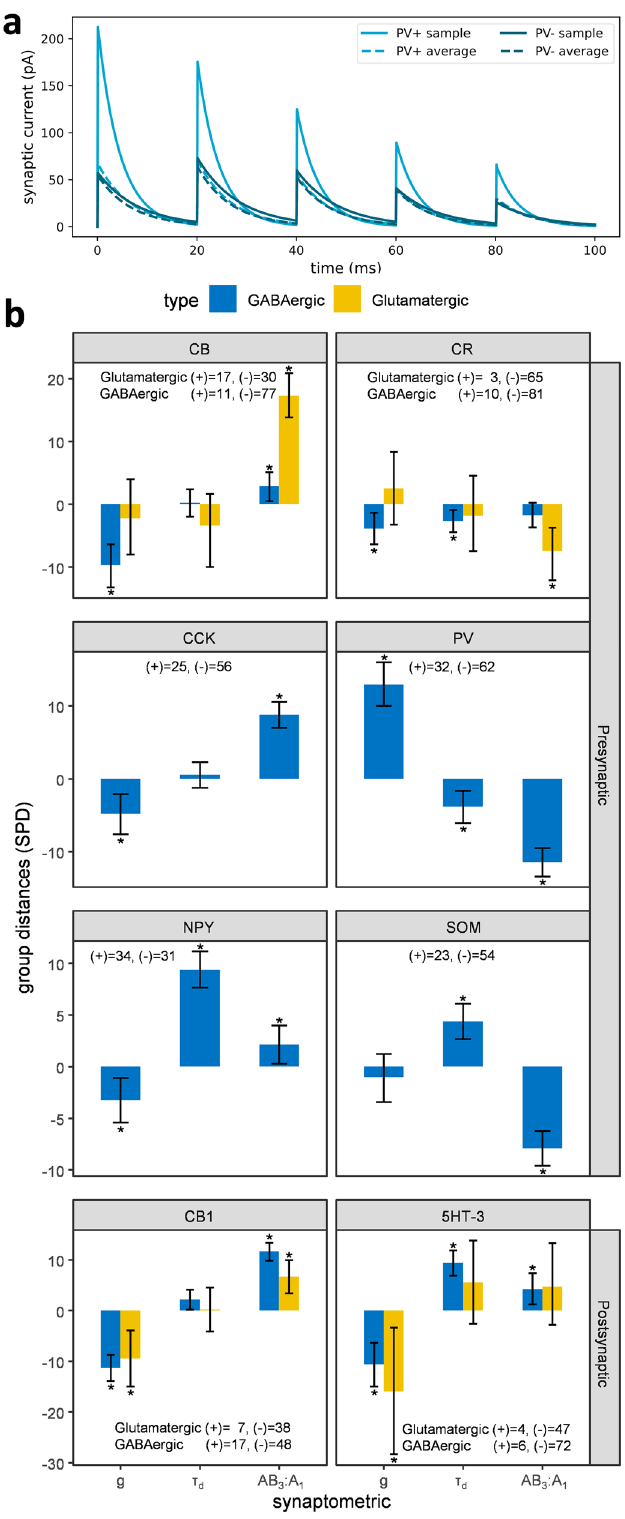
Fig. 8 Presynaptic and postsynaptic molecular markers of synaptic physiology. a Comparison of synaptic signals between presynaptic neuron types expressing ( + ) or not expressing ( − ) parvalbumin (PV). The consensus trace was simulated with synaptic parameters averaged across all potential connections in each group. The sample traces are from the CA1 Basket PV + to CA1 Pyramidal connection ( + ), and from CA1 Basket CCK + to CA1 Pyramidal ( − ). b Symmetric percentage differences (SPD) in synaptic parameters between potential connections grouped by the expression or absence of speci fi c presynaptic or postsynaptic molecular markers (with corresponding samples sizes). Positive values signify that the measurement is larger in the ( + ) than in the ( − ) group, and vice versa. Error bars indicate con fi dence intervals and asterisks denote statistical signi fi cance by unpaired Wilcoxon test at the p < 0.05 level after False Discovery Rate correction 63 for multiple testing. The dataset underlying this analysis and the listing of all 36 p-values are available in